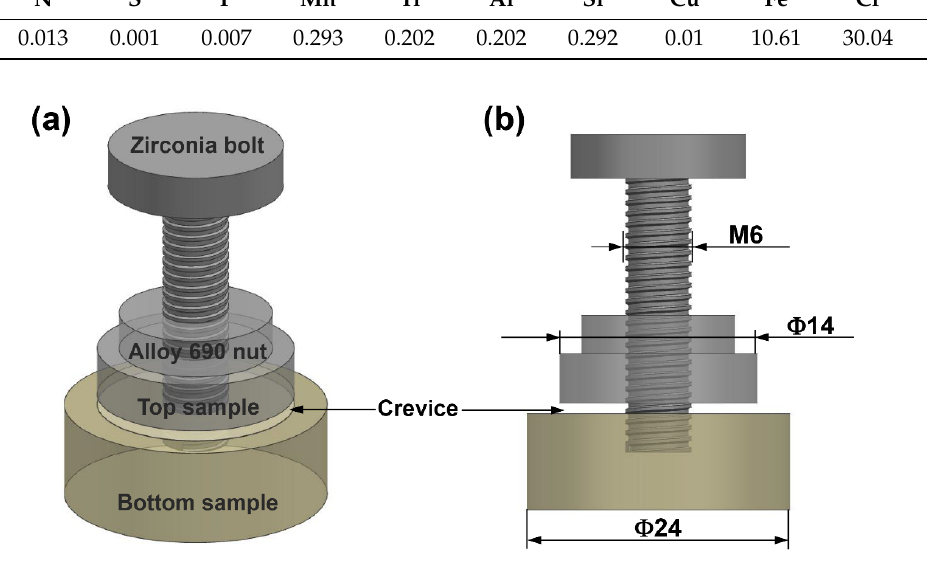
Figure 1. Schematic diagrams of ( a ) crevice corrosion device and ( b ) size of the crevice sample